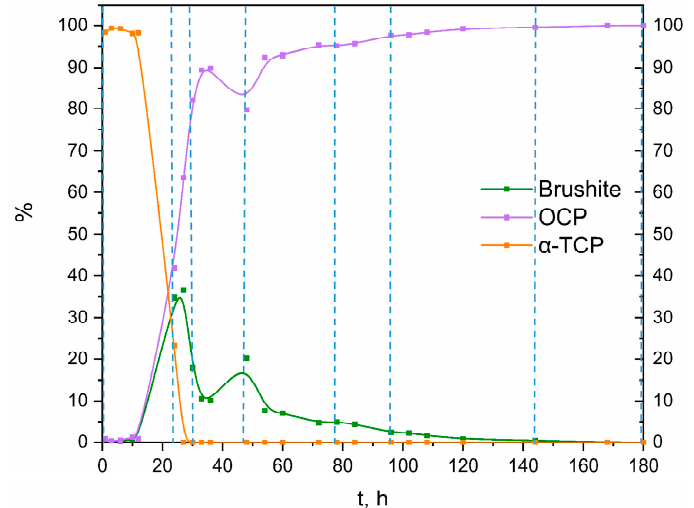
Figure 3. Quantitative analysis of the crystalline phases involved in the α -TCP transformation to OCP, based on XRD data from 100 × SC (after Rietveld refinement using Profex software [36]); vertical lines present the time points analyzed in detail in the main manuscript.